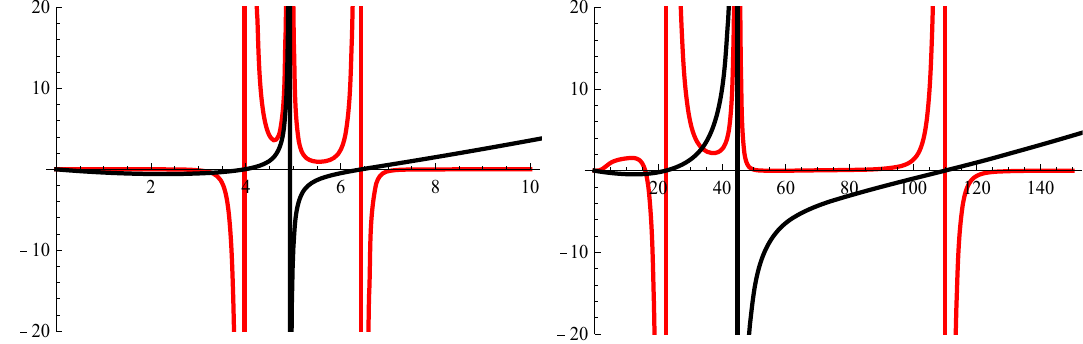
√ 3 , Q = 2. Right: 300 R and 0 . 1 C Q , α =